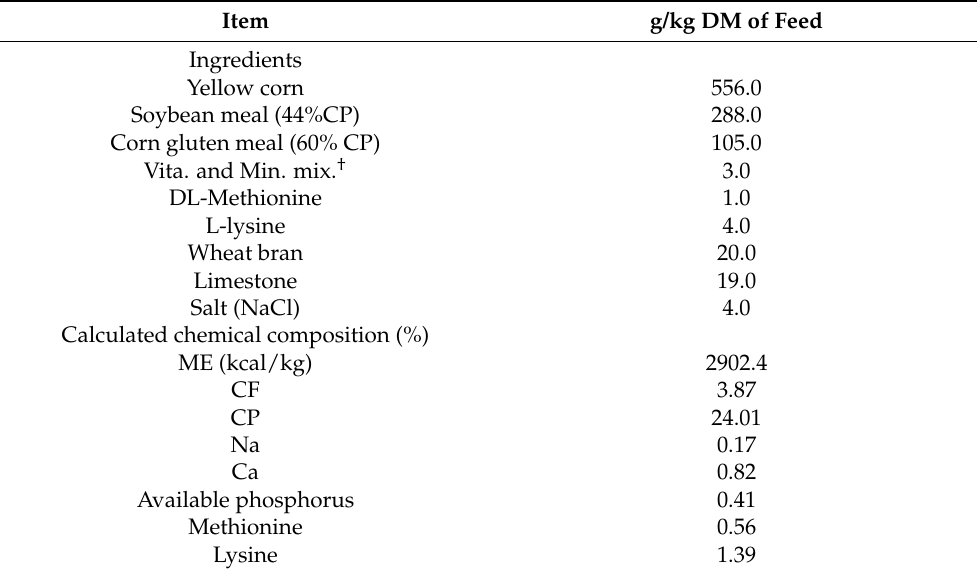
Table 1. Ingredients, composition, and calculated chemical analysis of the basal diets for growing